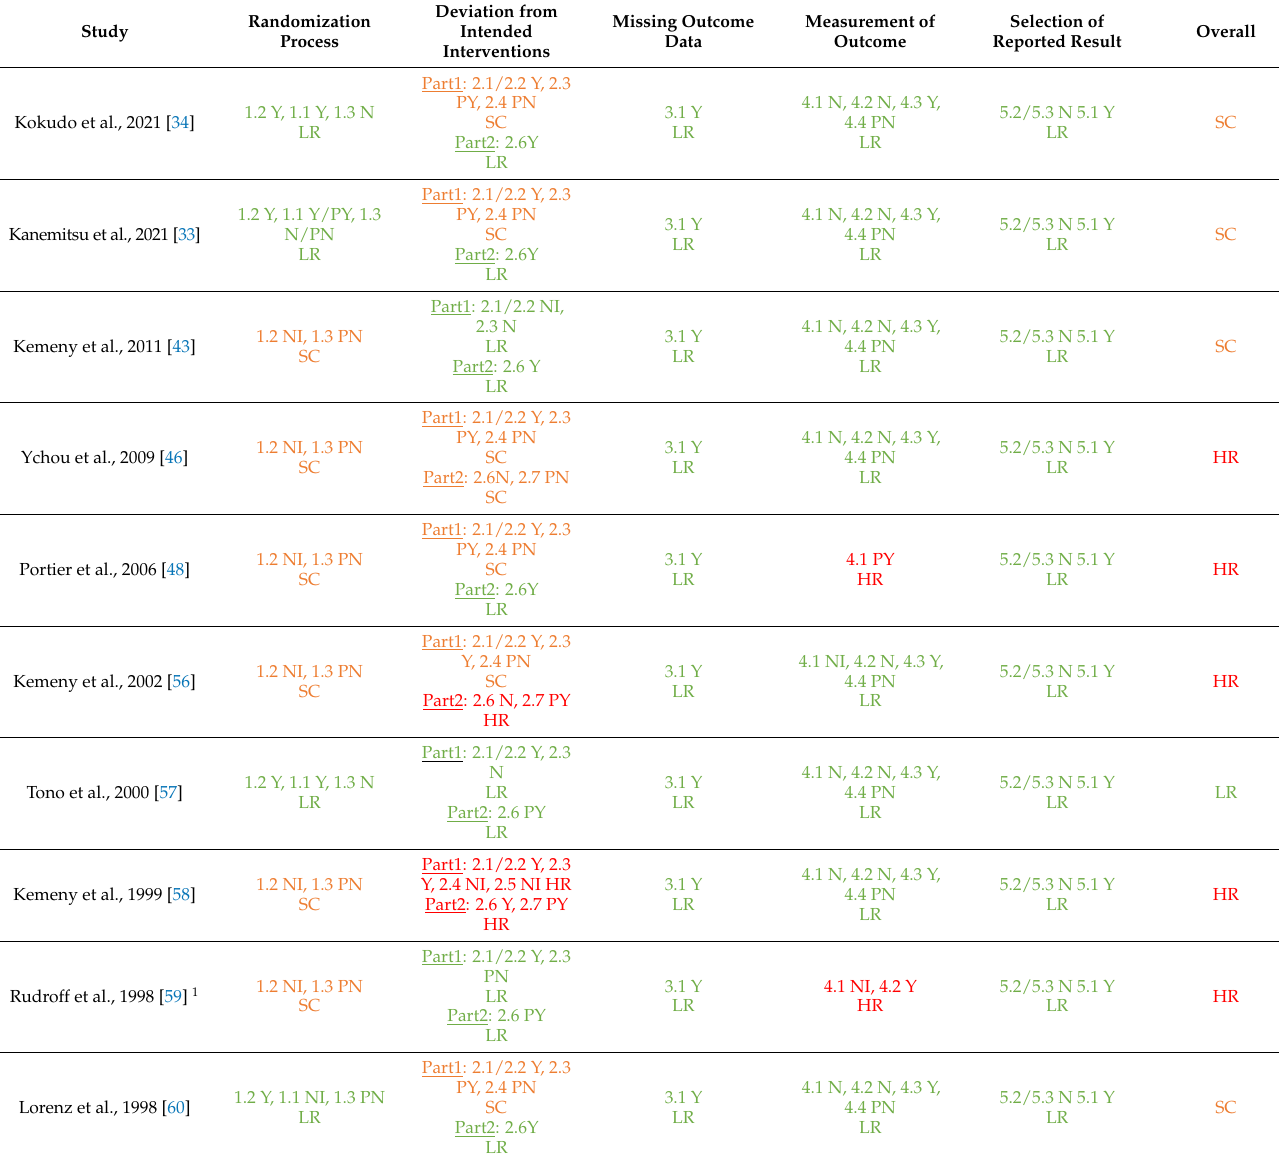
Table A1. Risk of bias assessment of randomized clinical trials according to RoB2 tool.